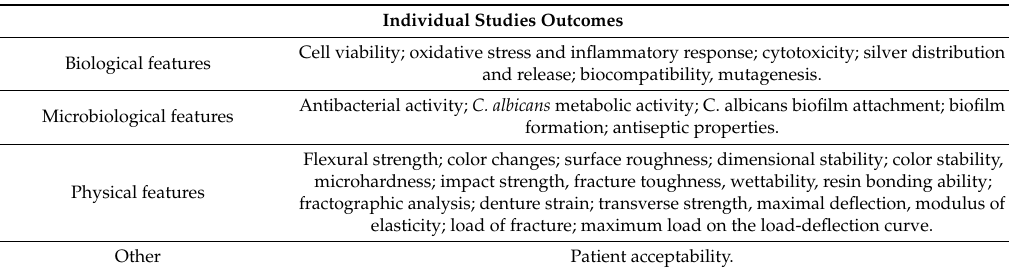
Table 3. Summary of individual outcomes. Individual Studies